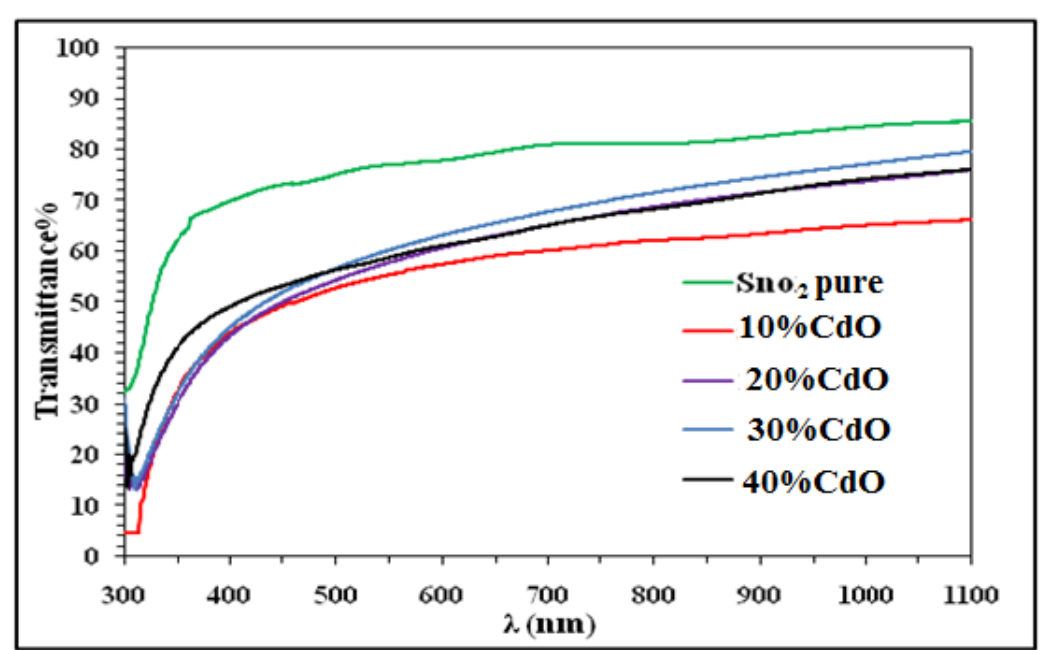
Fig. 3: Transmission as a function of the wavelength for un-doped Sno Cdo at different mixed